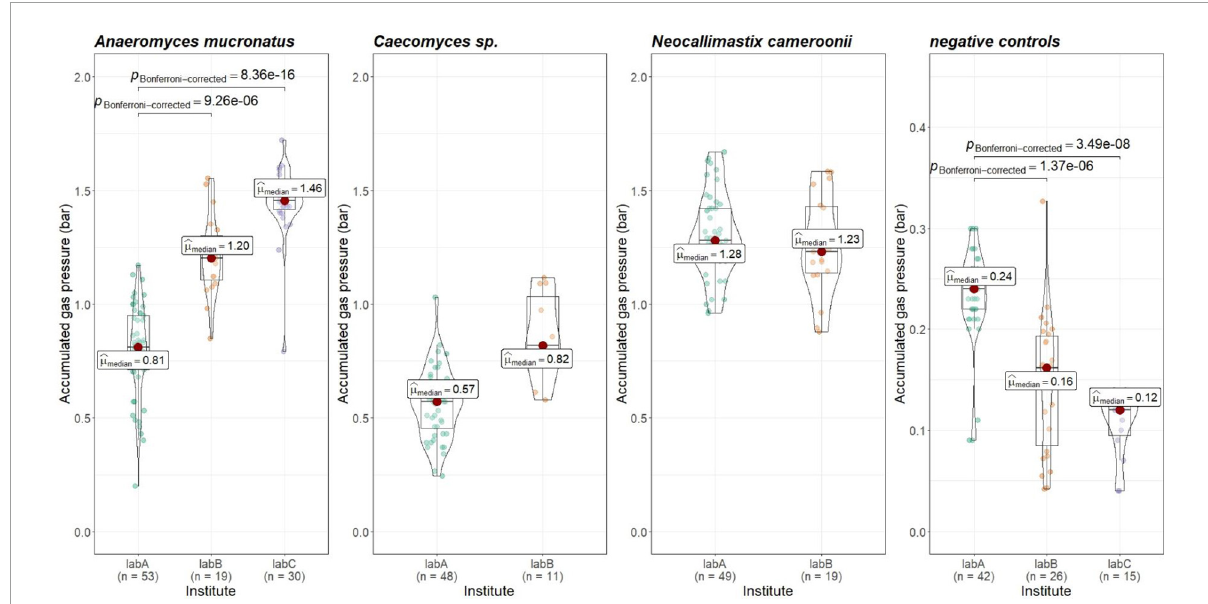
FIGURE5 Comparisons of accumulated gas pressure in the positive controls of the three different AF-methanogen co-cultures between the three partnering laboratories (lab A, lab B, lab C). Statistical tests: Kruskal–Wallis with post hoc Dunn-test. Only significant pairwise comparisons are shown. Caecomyces sp.: p = 3.50e-5, Neocallimastix cameroonii : p = 0.27.